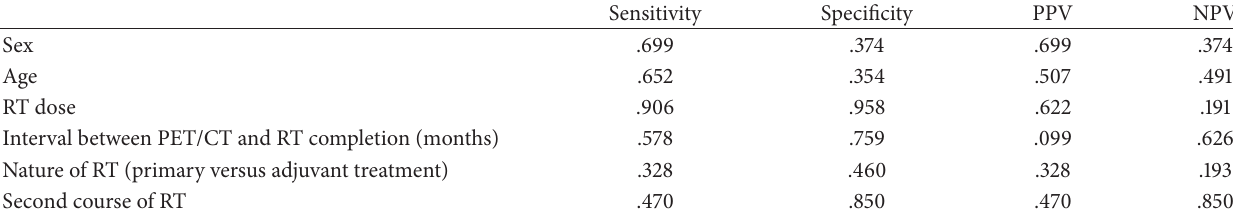
Table 3: Factors affecting diagnostic accuracy of PET/CT in irradiated neck.